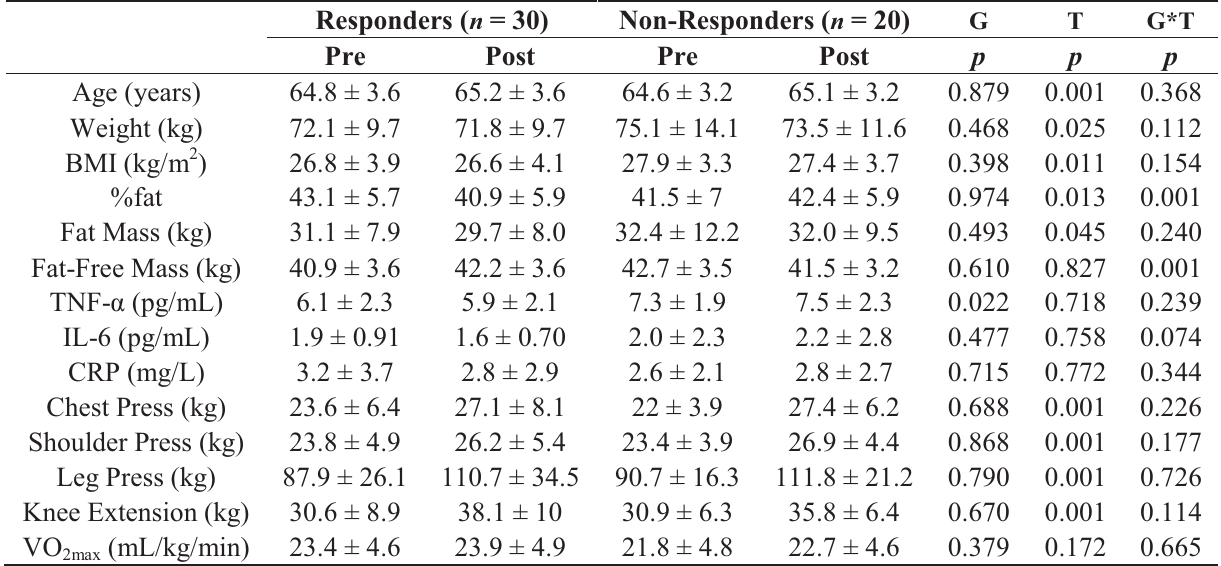
Table 1. Descriptive statistics and outcome variables pre- and 16 weeks post-training by responders vs.